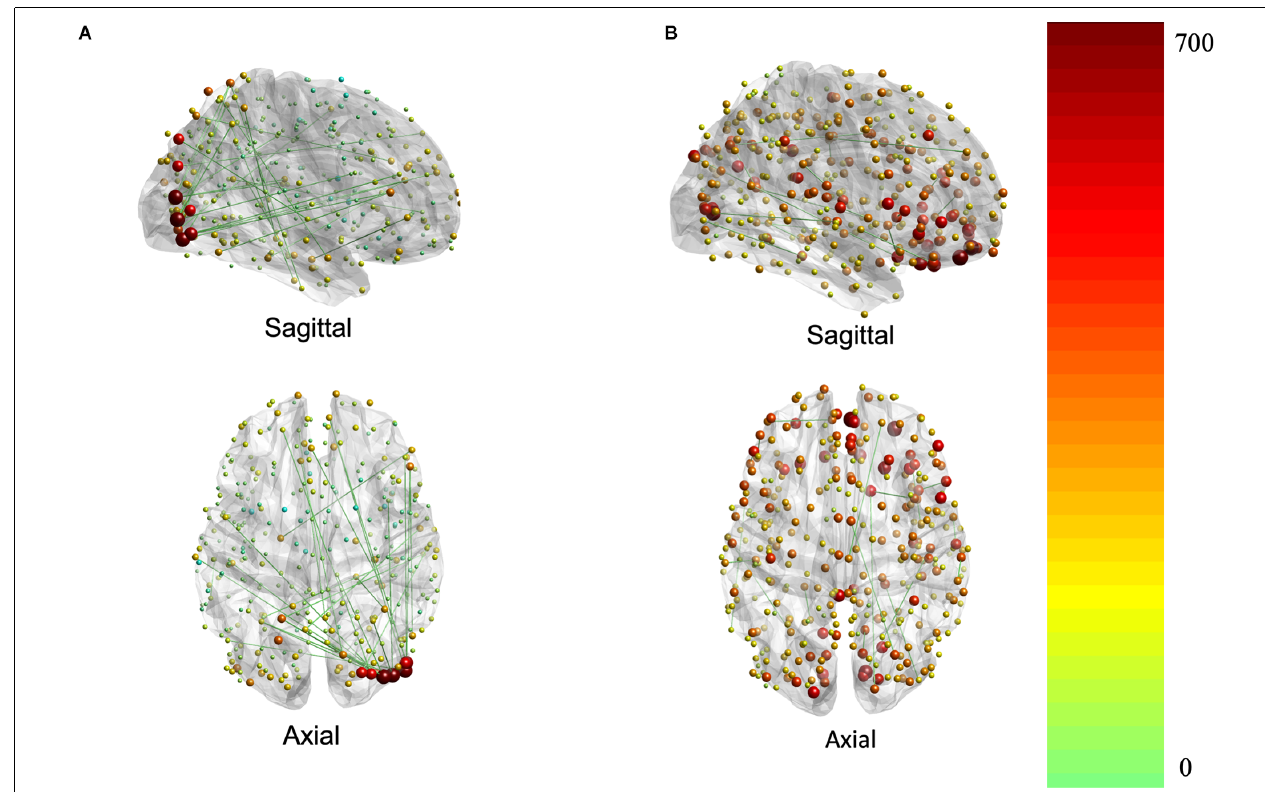
FIGURE 3 | Brain plots for FC (A) and SC (B) brain saliences. Brain regions are represented by nodes whose size and color code are proportional to their node strength. The node strength essentially represents the degree to which each connection contributes to the covariance pattern of behavior (red is higher strength while green is lower strength).